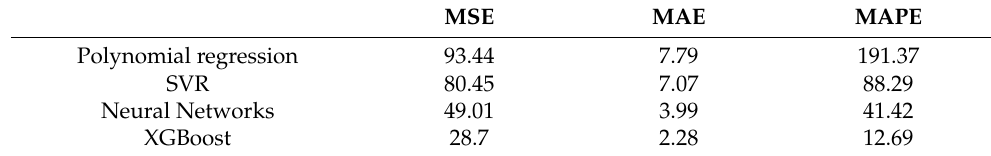
Table 7. Prediction and evaluation indicators of other regression models and XGBoost models.